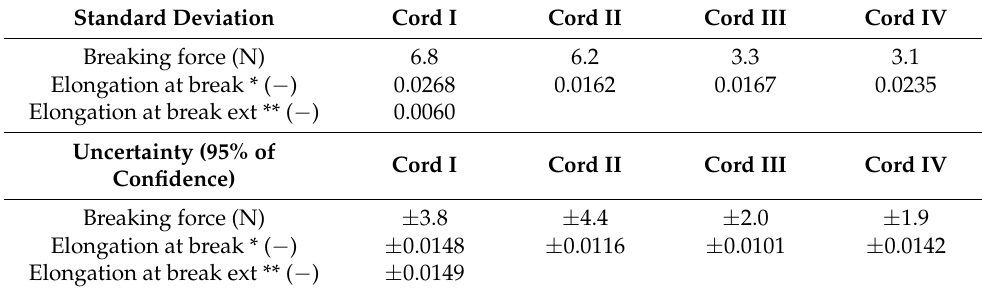
Table 3. Standard deviation and uncertainty with 95% of confidence of t achieved results. Standard